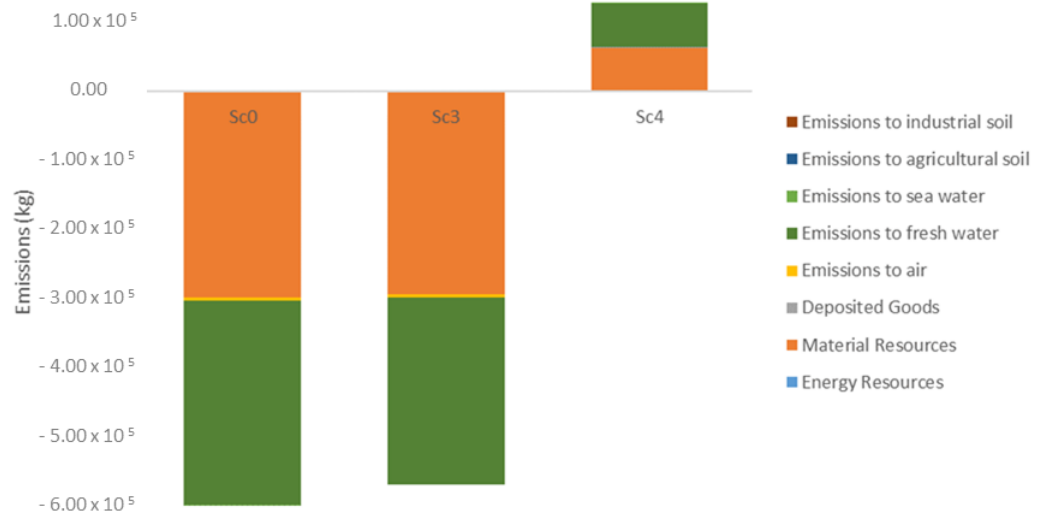
Figure 13. Balance comparison between the reference case (Sc0) and two other alternatives (Sc3 and Sc4). Results refer to one tonne of treated residues.